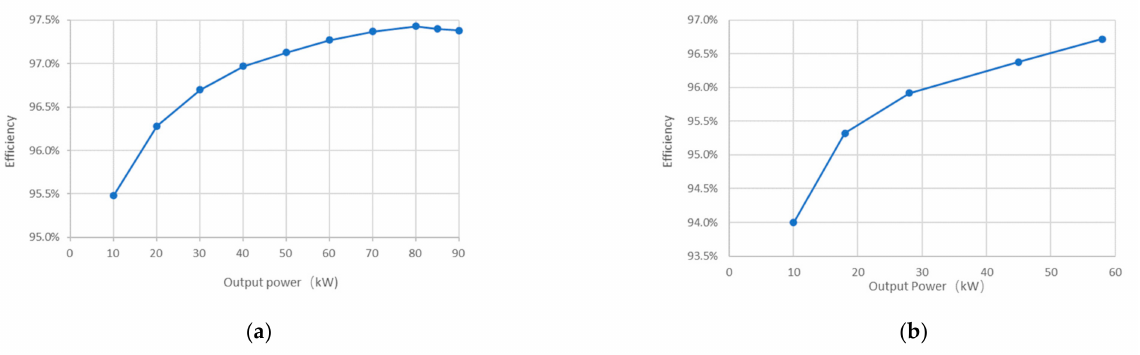
Figure 18. Measured efficiency of DC module. ( a ) Step-up mode; ( b ) Step-down mode.